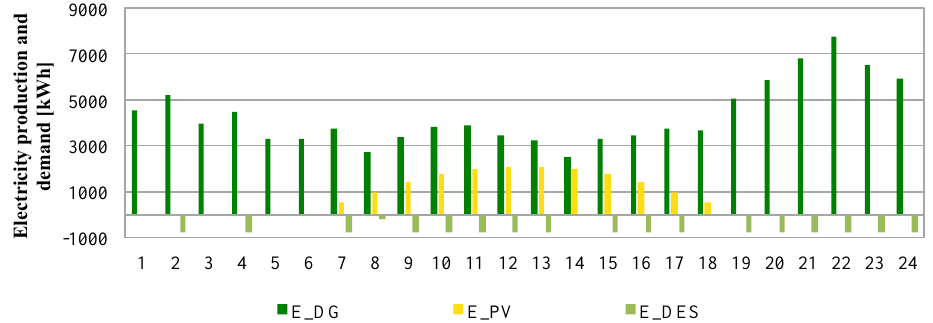
Figure 18. Optimal daily schedule of diesel generators and desalination units in August (maximum load month) in the TO-BE scenario 2. In this figure E_DG is the variable E DG , E_PV is the variable E PV and E_DES is the variable E DES.